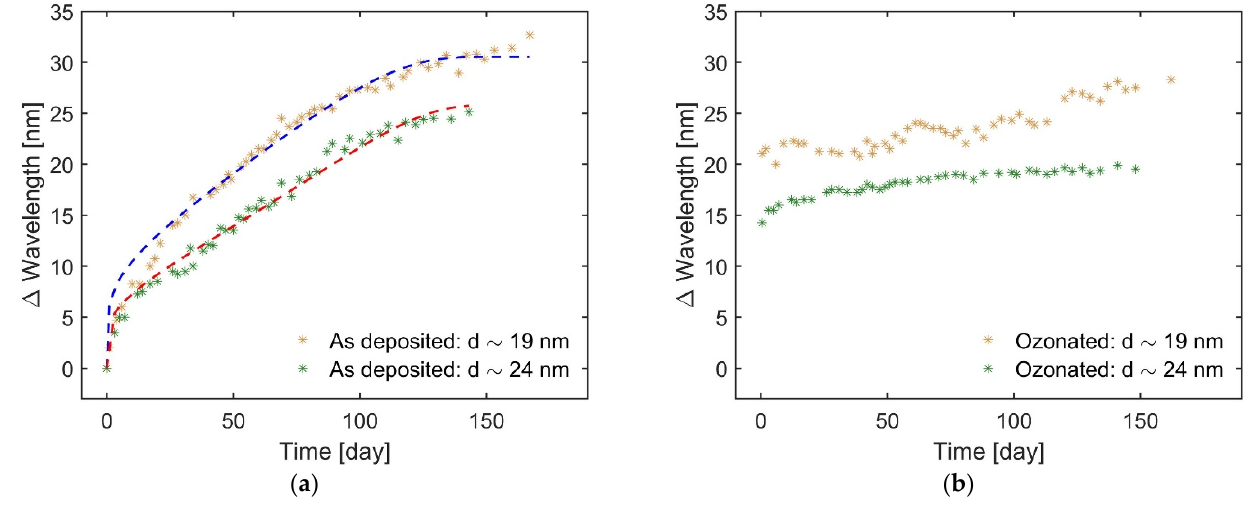
Figure 6. Time evolution of the resonance wavelength for ( a ) untreated and ( b ) UV-ozone treated Cu NPs. Dashed lines in ( a ) show the fits according to the model presented in the text. The linear regression coefficient R 2 is calculated to be 0.97 and 0.98 for 19 nm and 24 nm NPs, respectively.